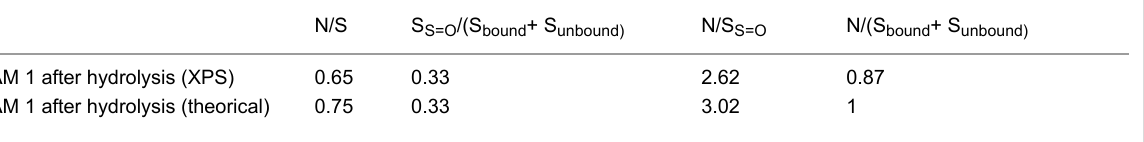
Table 3: Experimental (XPS) and theoretical characteristic ratios of the SAM 1 after hydrolysis. The theoretical ratios were calculated with a surface showing 67% of 4-ATP and 33% of the sulfamic acid derived from 4-ATP.